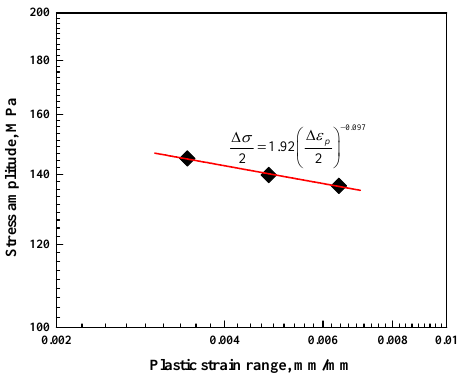
Figure 7. The cyclic stress–strain behavior of Alloy 617 at 950 °C determined through the Ramberg–Osgood relationship.